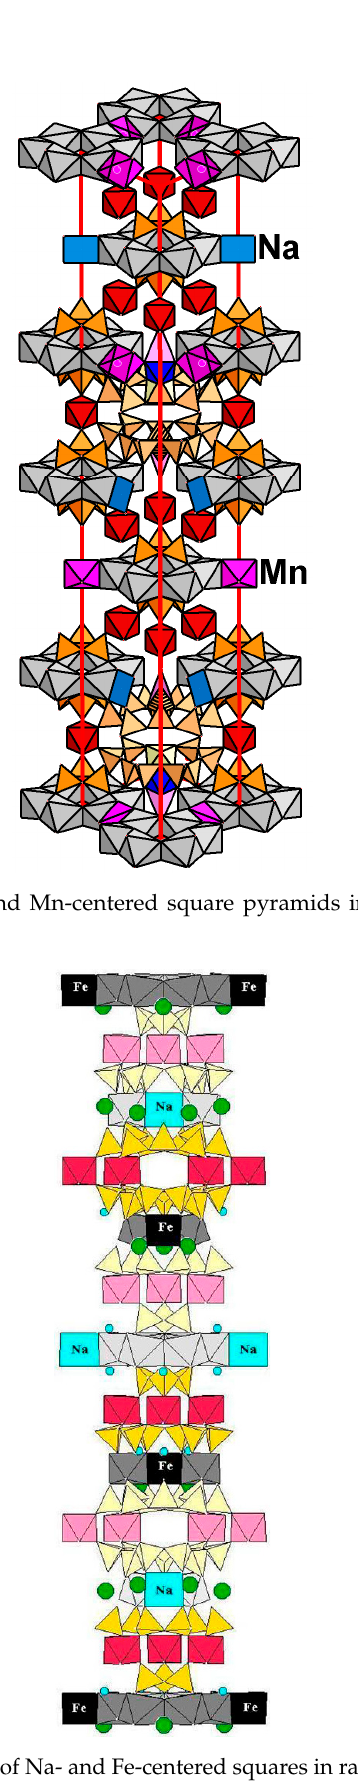
Figure 11. Alternation of Na- and Fe-centered squares in rastsvetaevite [49,50].